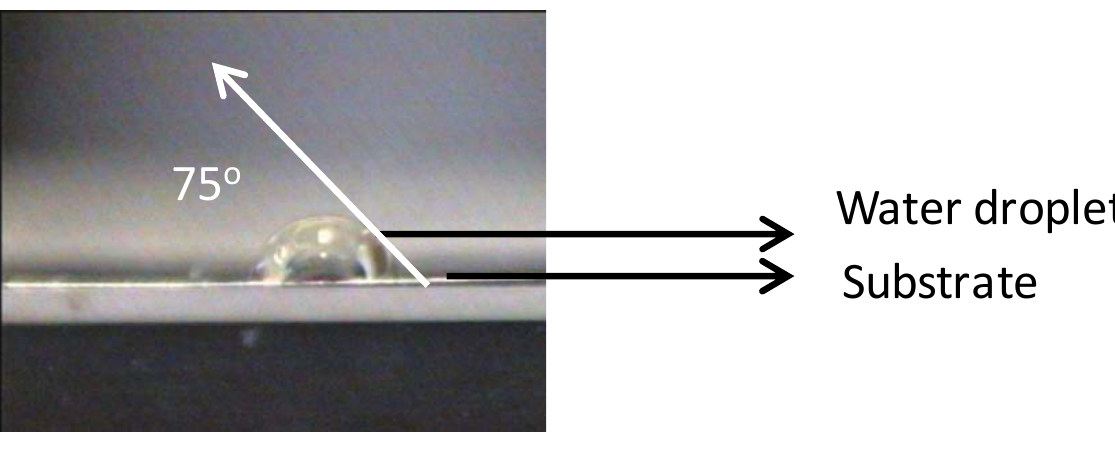
Figure 3. Non-wetting droplet of water on top of uncleaned Ni-5% W